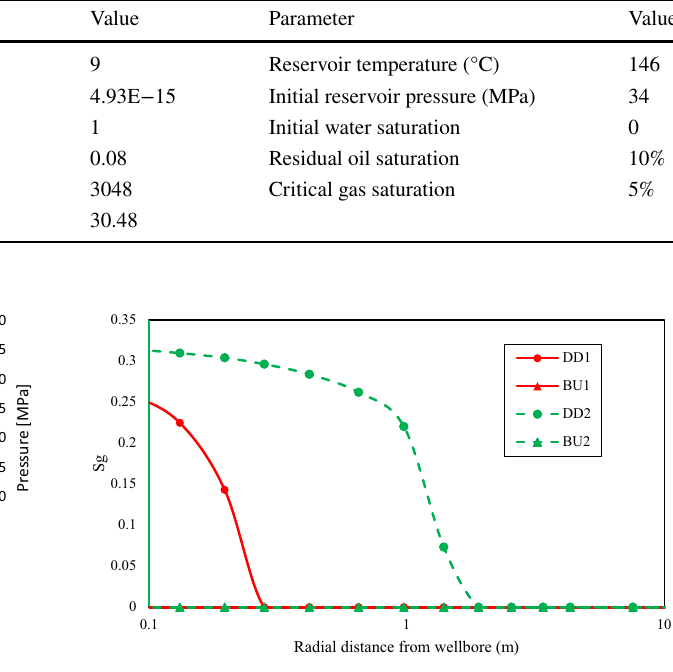
Fig. 6 Gas saturation profile at the end of DDs and BUs below P